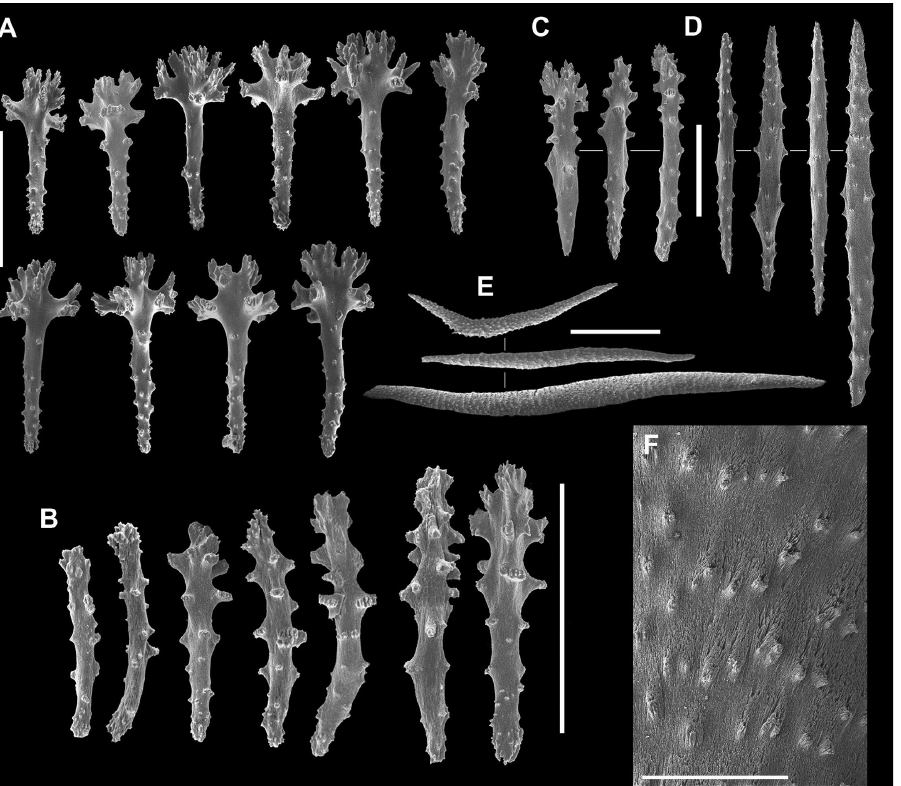
Figure 6. Sinularia lamellata RMNH Coel no. 12864. Sclerites of the polypary. A clubs of surface layer B–C point sclerites D spindles from surface E spindles from interior F tuberculation. Scale bars: 0.10 mm ( A–D, F ), 1 mm ( E